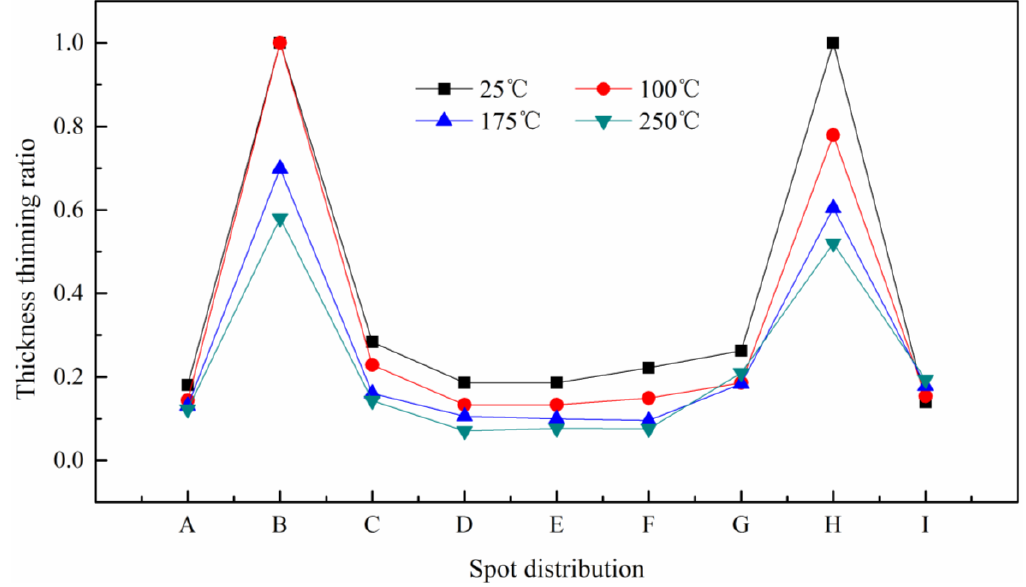
Figure 13. The distribution of thickness thinning ratio with different temperature at 1800 mJ.